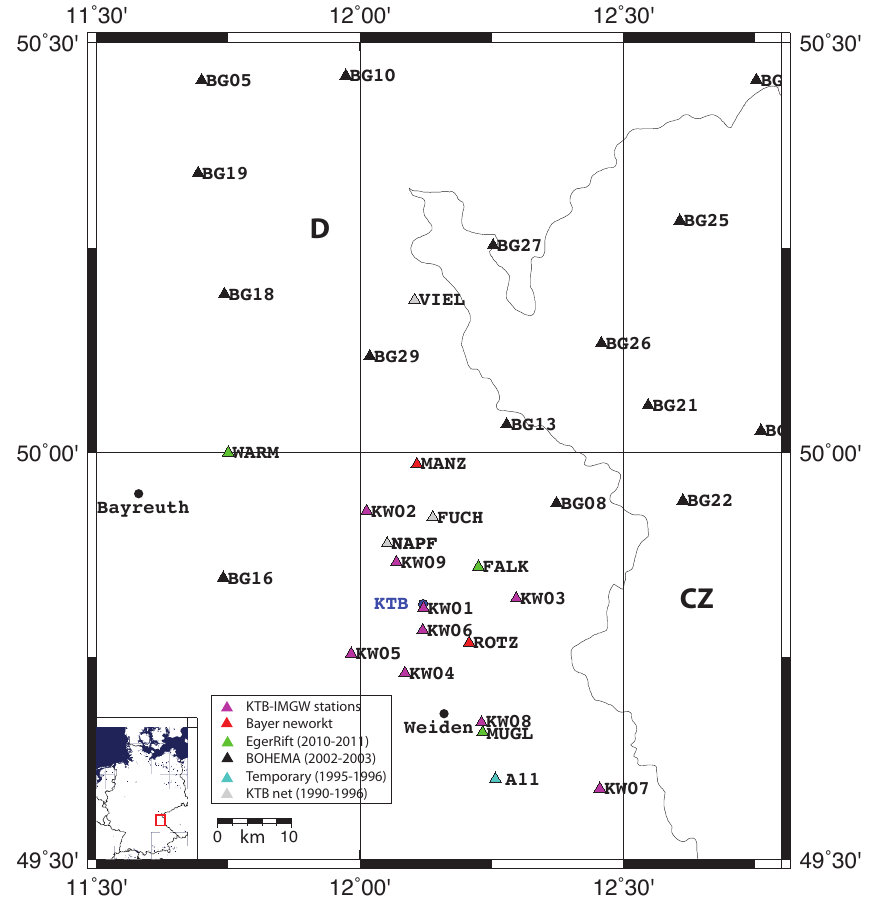
Figure 2. Map of the study are with seismic networks deployed in the study area since 1990. The blue circle represents the location of the KTB drilling site. In the inset a map of Germany with a red box displaying the location of the study area.